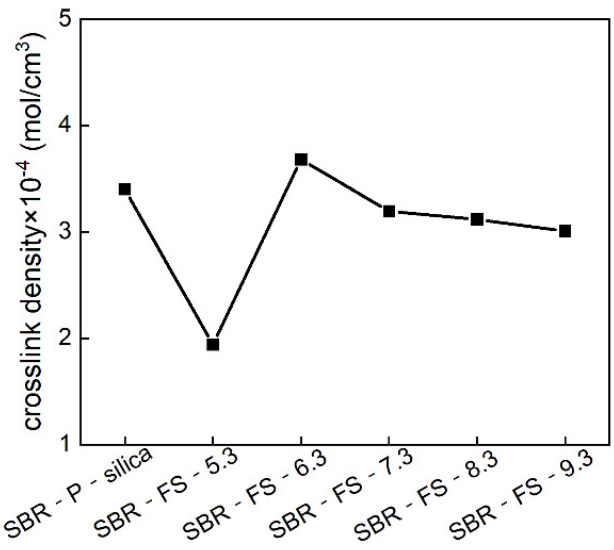
Figure 7. Crosslink density of the SBR rubber filled with P-silica and FS-SiO 2 . In short, FS-SiO 2 , with a high specific surface area, an appropriate amount of surface hydroxyl, and a small particle size, contributed to a higher crosslink density, which enhanced the mechanical performance.